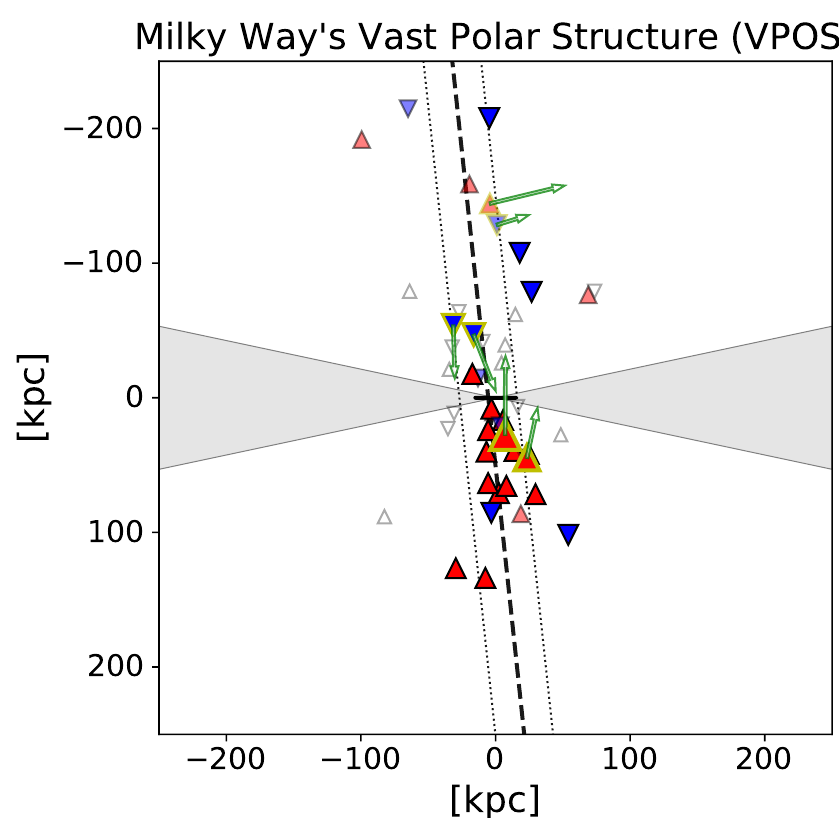
Figure 2. Distribution of dwarf galaxies around the Milky Way. The Milky Way is seen edge-on in the center (black line), with grey shaded areas indicating a ± 12 ◦ region around the disk plane that is obscured and where dwarf galaxy searches are expected to be most incomplete. The view is oriented to show the Vast Polar Structure (VPOS) edge-on, which is illustrated with a black dashed line, and its root-mean-square width is indicated with the dotted lines. The dwarf galaxy positions are indicated with upward (downward) pointed triangles, indicating whether a dwarf is moving into (out of) the plot. The dwarfs that are likely or possibly orbiting along the VPOS are colored according to their most likely motion (red is receding from the viewer into the plot, blue is approaching out of the plot). Dwarfs which are consistent within their proper motion uncertainties are shown in light colors; dwarfs which are clearly not part of the VPOS are shown as empty symbols. Three proposed pairs of satellite galaxies are highlighted with yellow contours. These are, from top to bottom: LeoIV and LeoV, Draco and Ursa Minor, and the LMC and SMC. Their most likely velocities in this projection (from [49]) are indicated with green arrows. They are consistent with following similar orbital directions. Draco, Ursa Minor, and both Magellanic Clouds are also consistent with co-orbiting along the VPOS; LeoIV and LeoV have only weakly constrained proper motions but share a very similar